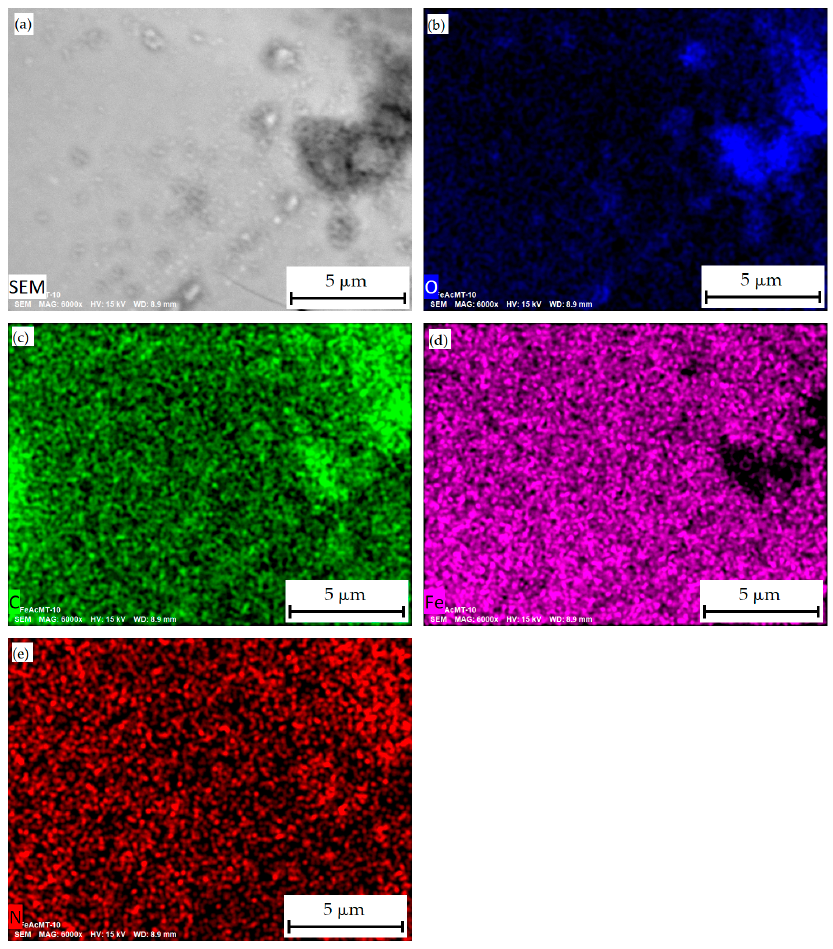
Figure 7. SEM-image of morphology of FeAcMTX conjugate nanoparticles ( a ) and its elemental mappings: C ( b ), O ( c ), Fe ( d ), and N ( e ). The elemental composition of the FeAcMTX conjugate is presented in the EDX spec- trum (Figure 8).